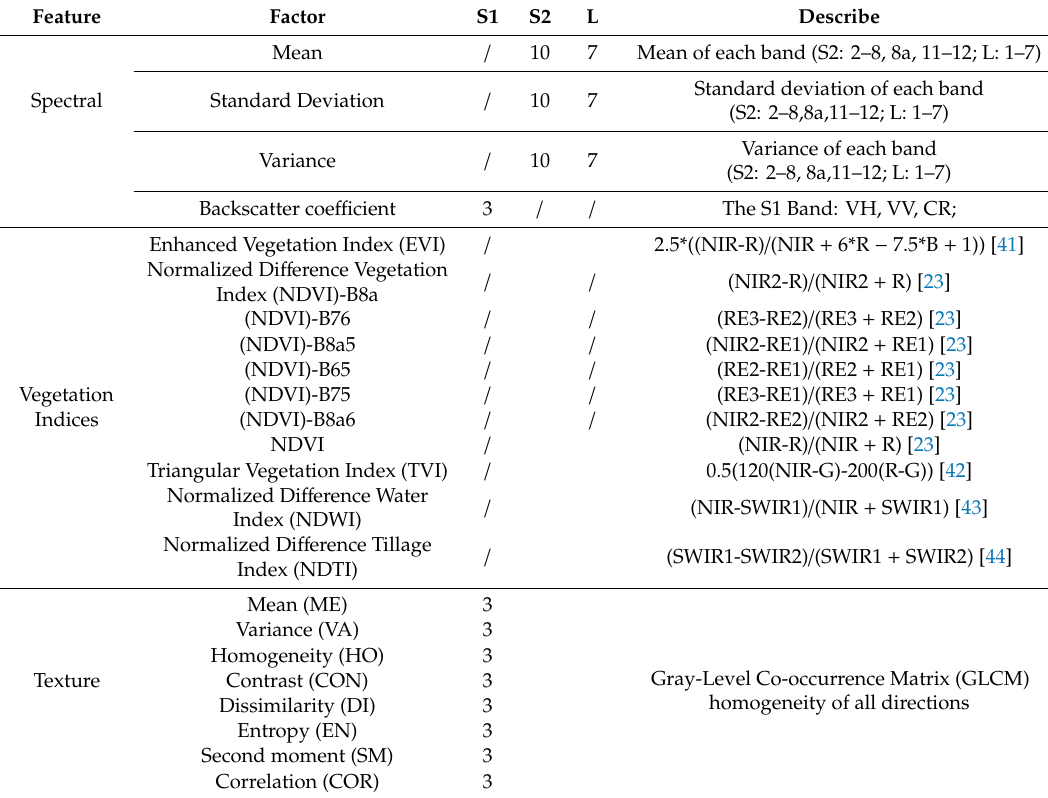
Table 4. Features extracted from spectral vegetation and texture